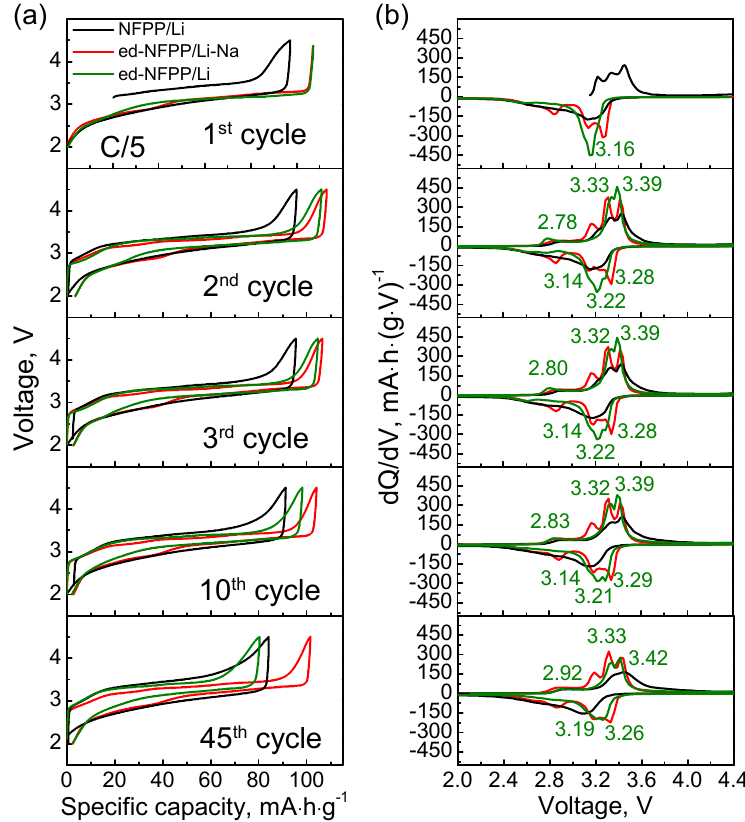
Figure 2. Charge-discharge profiles ( a ) and dQ/dV vs. voltage plots ( b ) at different cycles for three electrochemical cells: A pristine NFPP in a Li cell with the Li electrolyte (NFPP/Li), a de-sodiated NFPP with the mixed 0.9Li-0.1Na electrolyte (ed-NFPP/Li-Na), and a de-sodiated NFPP with the Li electrolyte (ed-NFPP/Li).